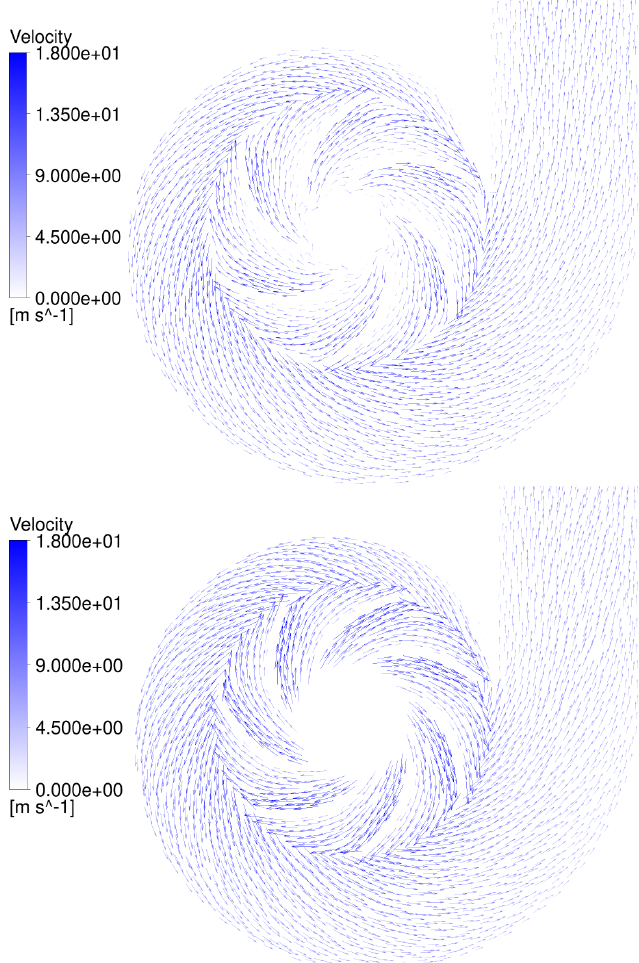
Figure 23. Velocity vectors (relative velocity for the impeller and absolute velocity for the volute) for the baseline ( top ) and the optimized ( bottom ) geometries, z = 5